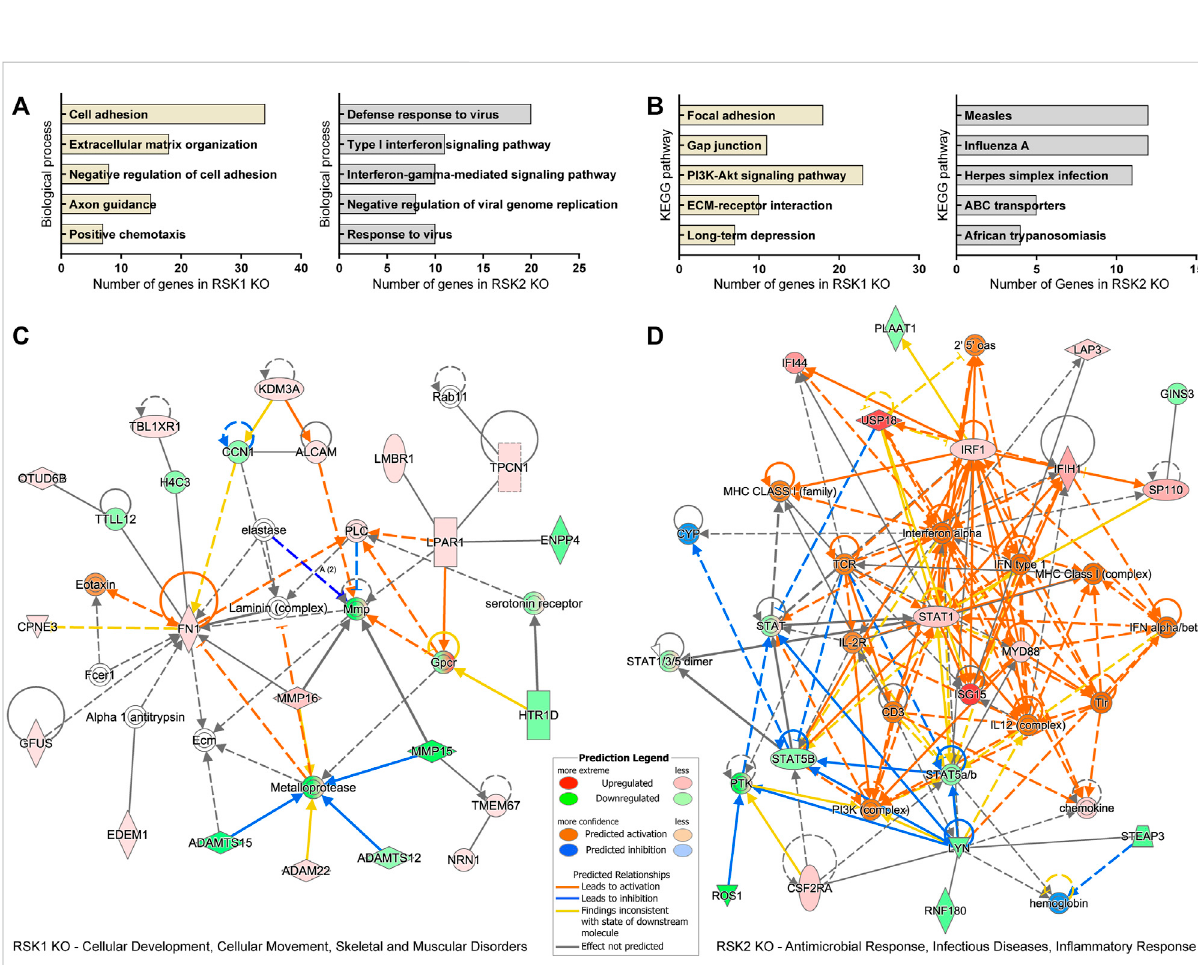
Gene Ontology (GO) analysis of biological processes, KEGG pathway and IPA network pathway analysis of DEGs speci fi c to RSK1 KO and RSK2 KO. (A) Top fi ve biological processes analyzed from RSK1 KO-speci fi c DEGs (left) and RSK2 KO speci fi c DEGs (right) in EGF stimulation. All collected biological processes were generated using the Database for Annotation, Visualization, and Integrated Discovery (DAVID). Bars represent the number of genes related to the indicated pathways ( p < 0.05). (B) Top fi ve KEGG pathways analyzed from RSK1 KO-speci fi c DEGs (left) and RSK2 KO-speci fi cDEGs (right) in EGF stimulation. (C) Genenetworkfor ‘ Cellular Development, Cellular Movement, Skeletal and Muscular Disorders ’ from RSK1 KO-speci fi c DEGs. (D) Gene network for ‘ Antimicrobial Response, Infectious Diseases, In fl ammatory Response) from RSK2 KO-speci fi c DEGs. Gene networks based on IPA scores were identi fi